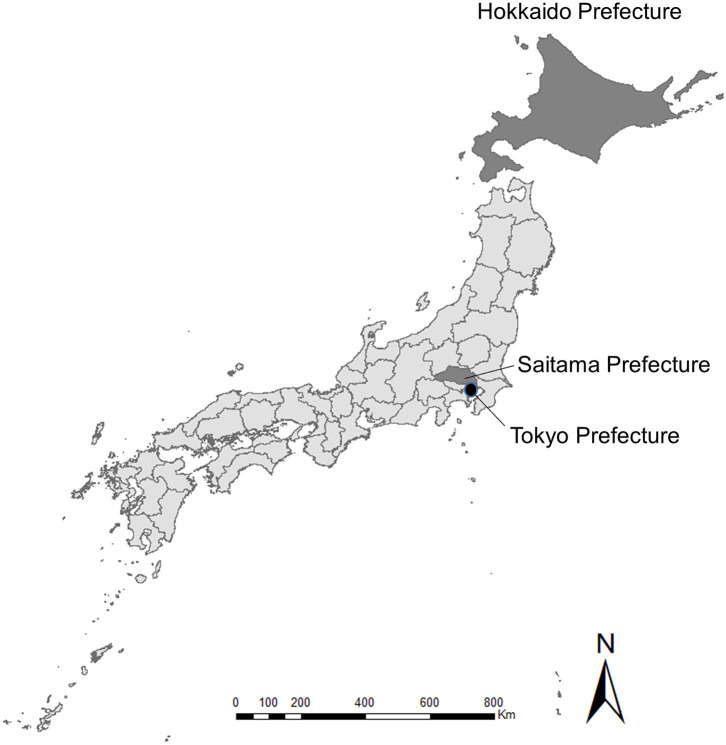
A map of Japan indicating the locations of Hokkaido, Saitama, and Tokyo Prefectures.